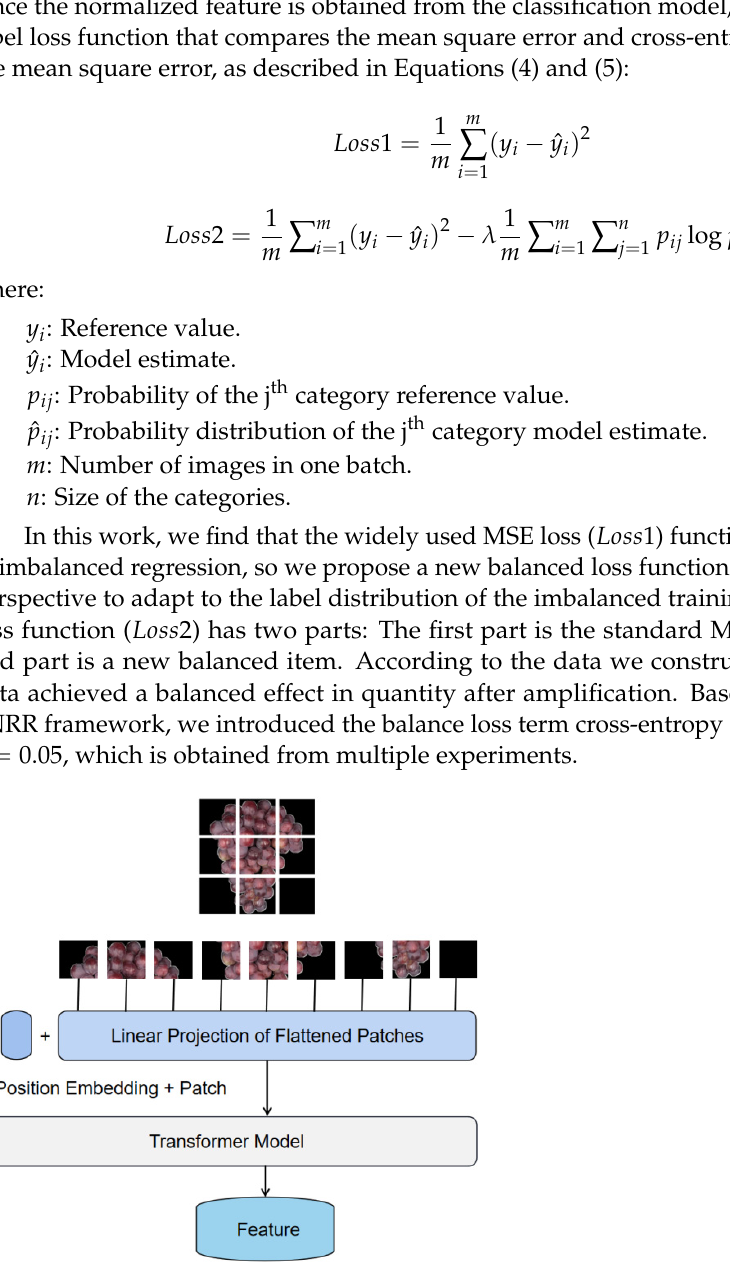
Figure 5. Grape feature extraction based on transformer model.